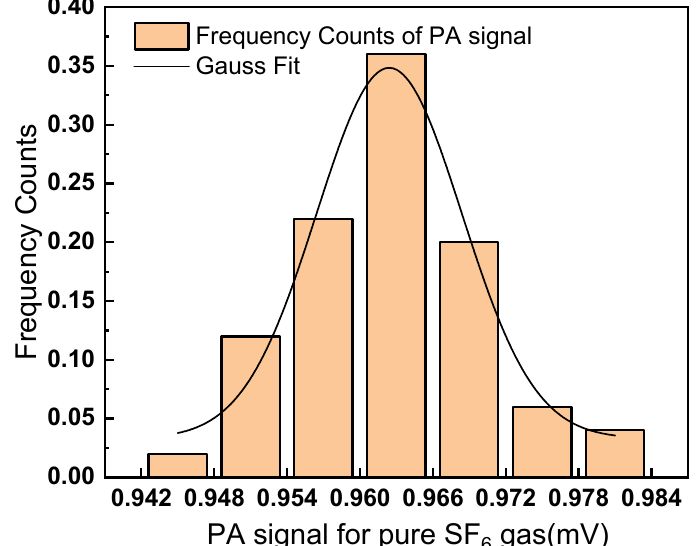
Figure 10. Frequency of the 50 times test results for pure SF 6 gas.